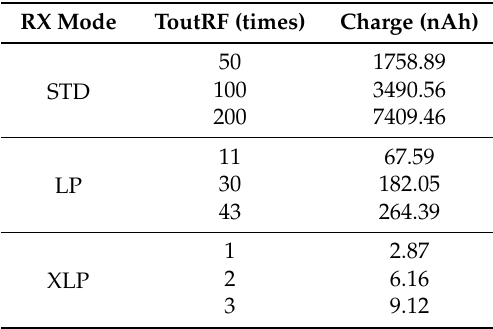
Table 8. Electric charge drained in reception.